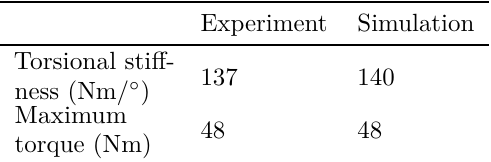
Table 4. Comparison of experimental results and predicted values.